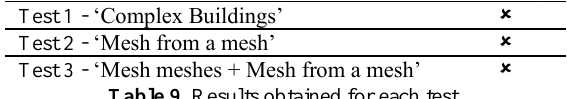
Table 9. Results obtained for each